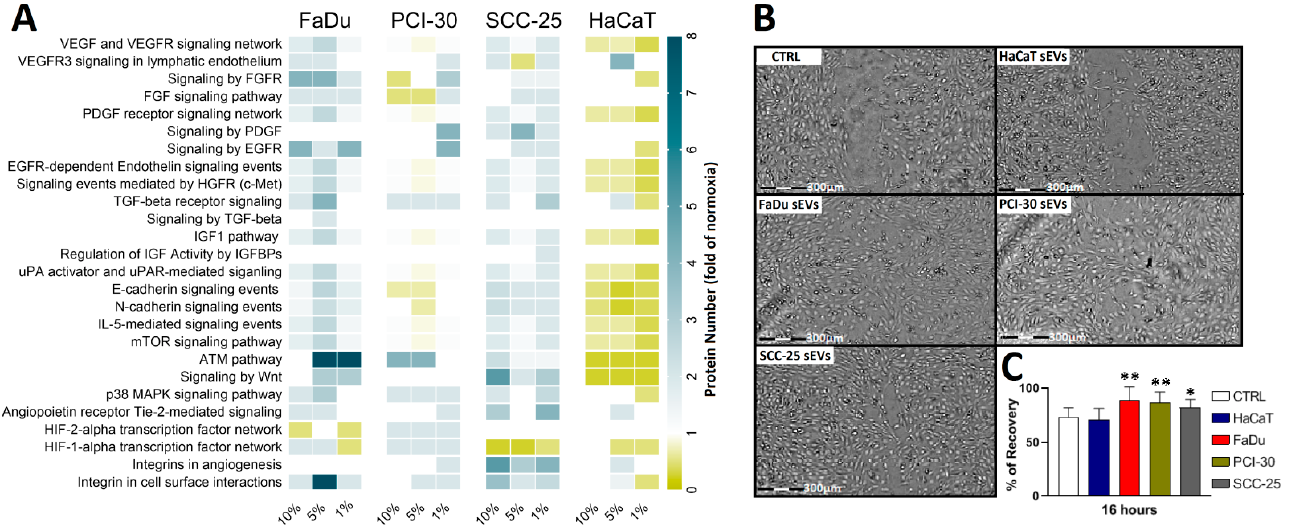
Figure 6. Hypoxic conditions stimulate the release of small extracellular vesicles (sEVs) from Head and Neck Squamous Cell Carcinoma (HNSCC) cells with pro-angiogenic functions. ( A ) Number of proteins related to pro-angiogenic pathways identified in sEVs produced by HNSCC cells exposed to various levels of hypoxia. Data are presented as fold of normoxia (21% O 2 ). ( B ) Representative microscope images of wound healing assay of Human Umbilical Vein Endothelial Cells (HUVECs) co-incubated for 16 h with 3 µL phosphate buffered saline (CTRL) or 3 µg of sEVs at a concentration of 1 µg/µL isolated from 5% O 2 HaCaT, FaDu, PCI-30, SCC-25. ( C ) Quantification of wound closure. All values represent means ± SEM (* p < 0.05; ** p < 0.01).